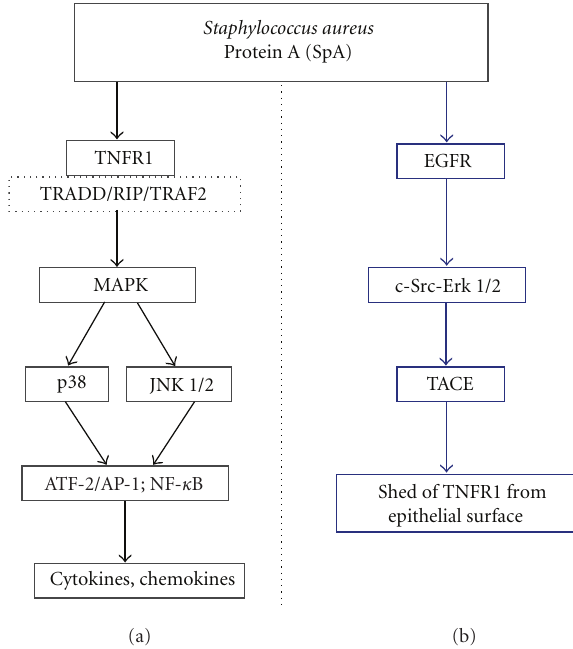
Figure 1: Role of SpA in TNFR1 regulation. (a) SpA is recognized by TNFR1 and the signaling cascade is initiated through the adaptor proteins TRADD/RIP/TRAF2, which subsequently activate MAPK kinases (p38 and JNK 1/2) and induce translocation of transcription factors AP-1 and NF- κ B into the nucleus. Activation of AP-1 and NF- κ B leads to transcription of genes encoding proinflammatory cytokines and chemokines. (b) SpA through interaction with EGFR and activation of c-Src-Erk1/2 stimulates the activity of TACE (ADAM-17), which cleaves and releases TNFR1 from the airway surface. TNFR1 is then available to neutralize free SpA and TNF- α ligands. AP-1, activator protein 1; ATF-2, activating transcription factor 2; EGFR, epidermal growth factor receptor; NF- κ B, nuclear factor κ B; RIP, receptor-interacting protein; TACE, tumor necrosis factor- α -converting enzyme; TNFR1, tumor necrosis factor recep- tor 1; TRADD, tumor necrosis factor receptor- (TNFR-) associated death domain; TRAF2, tumor necrosis factor receptor-associated factor